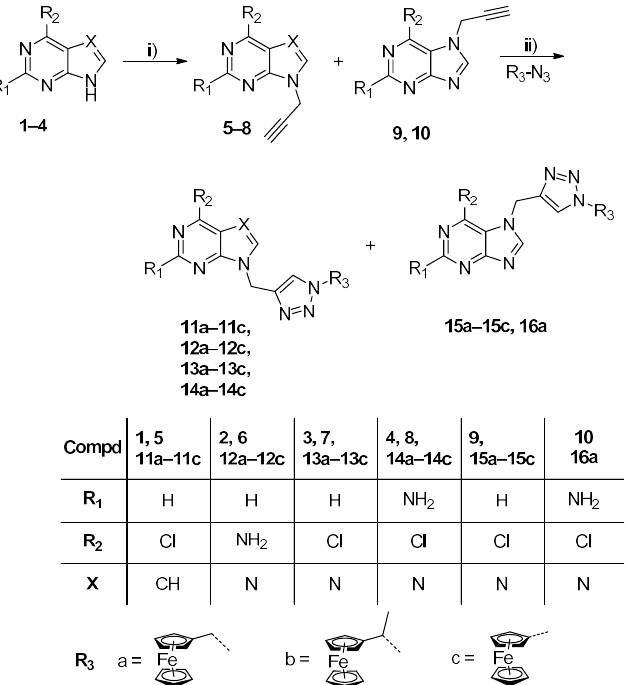
Scheme 1. Synthesis of novel purine and 7-deazapurine derivatives linked to C-4 of 1,2,3-triazolyl ferrocene. Reagents and conditions : (i) propargyl bromide, NaH, anhydrous DMF, Ar atmosphere, 60 °C, 24 h; (ii) corresponding azide, Cu(OAc) 2 , methanol, room temperature, 24 h.